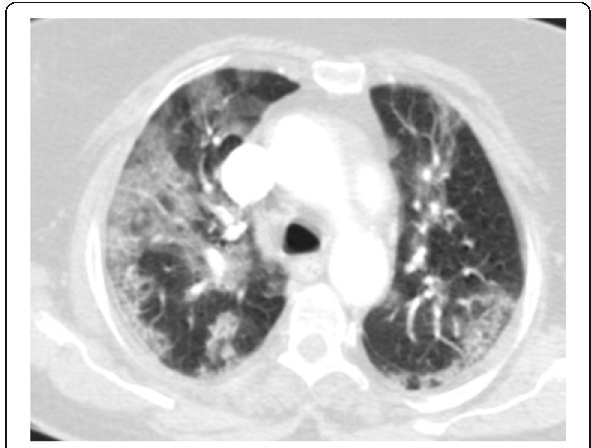
Fig. 7 COVID-19 pneumonia: thin section CT shows bilateral multifocal subpleural and peribronchial GGO and reticulation (crazy -paving appearance)